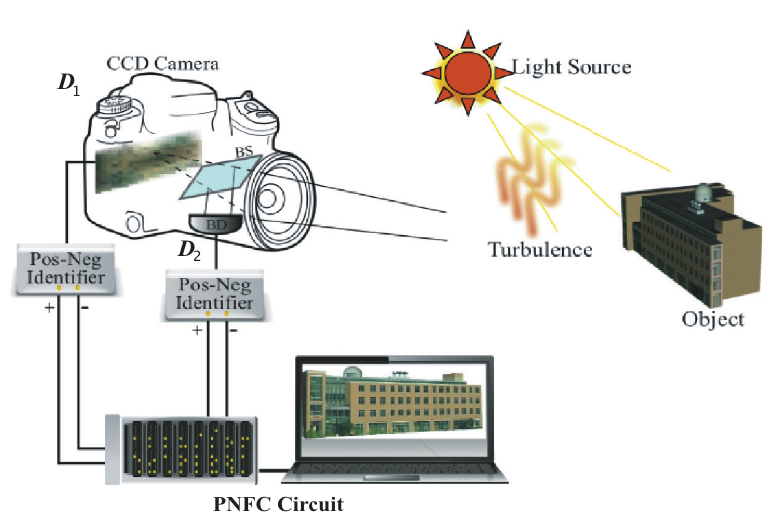
Figure 2. Imaging from “noise”: an image of the target object, which is under the influence of atmospheric turbulence, is produced from the correlation measurement of (cid:104) ∆ n ( (cid:126) ρ i 1 ) ∆ n ( (cid:126) ρ i 2 ) (cid:105) or ∆ n ( (cid:126) ρ (cid:104) ∆ n ( (cid:126) ρ ) (cid:82) d (cid:126) ρ ) (cid:105) . This figure illustrates the later measurement: the “bucket” detector (BD) sums i 1 i 2 i 2 over the fluctuations at all (cid:126) ρ i 2 , using the integrated fluctuations for the joint measurement paired with that of each element of the CCD (Charge-Coupled Device) array ( (cid:126) ρ i 2 ). The classical images in (cid:104) n i 1 (cid:105) and (cid:104) n (cid:105) are both “blurred” due to the influence of atmospheric turbulence. However, the observed image i 2 (cid:82) d (cid:126) ρ i 2 ∆ n ( (cid:126) ρ i 2 ) (cid:105) , are turbulence-free. In this setup the turbulence in (cid:104) ∆ n ( (cid:126) ρ i 1 ) ∆ n ( (cid:126) ρ i 2 ) (cid:105) , and/or (cid:104) ∆ n ( (cid:126) ρ i 1 ) may appear either in the optical pass between the camera and the object or in the optical pass between the object and the light source, or appear in both